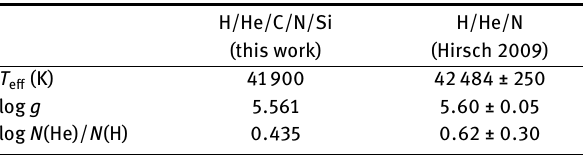
Hirsch (2009) with error estimates from spectrum-to-spectrum vari- ations.